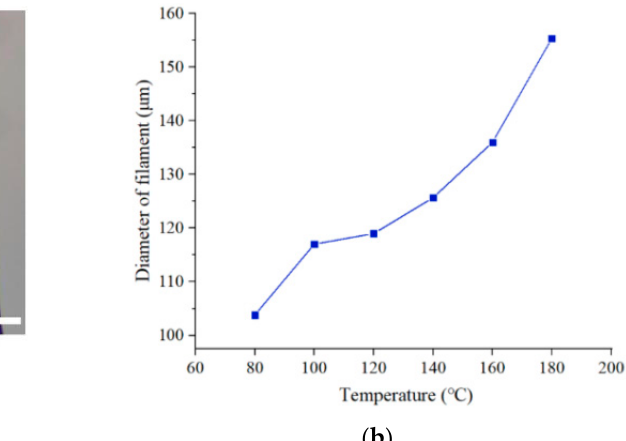
Figure 8. ( a ) Storage and loss modulus of PLCL with various temperatures; ( b ) viscosity curves of PLCL with various temperatures.